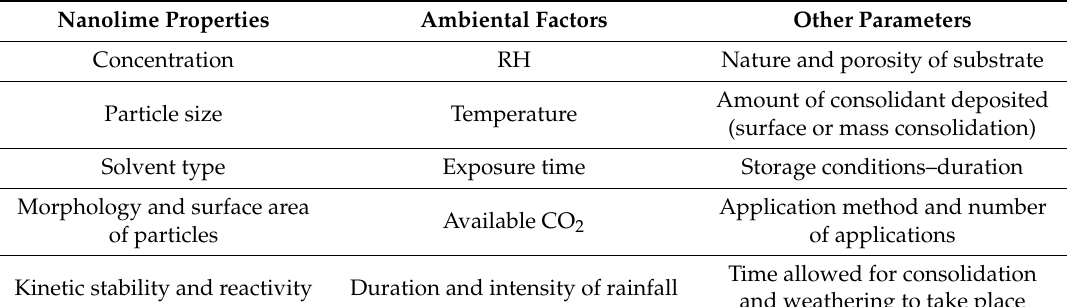
Table 3. Factors influencing the e ff ectiveness of nanolime